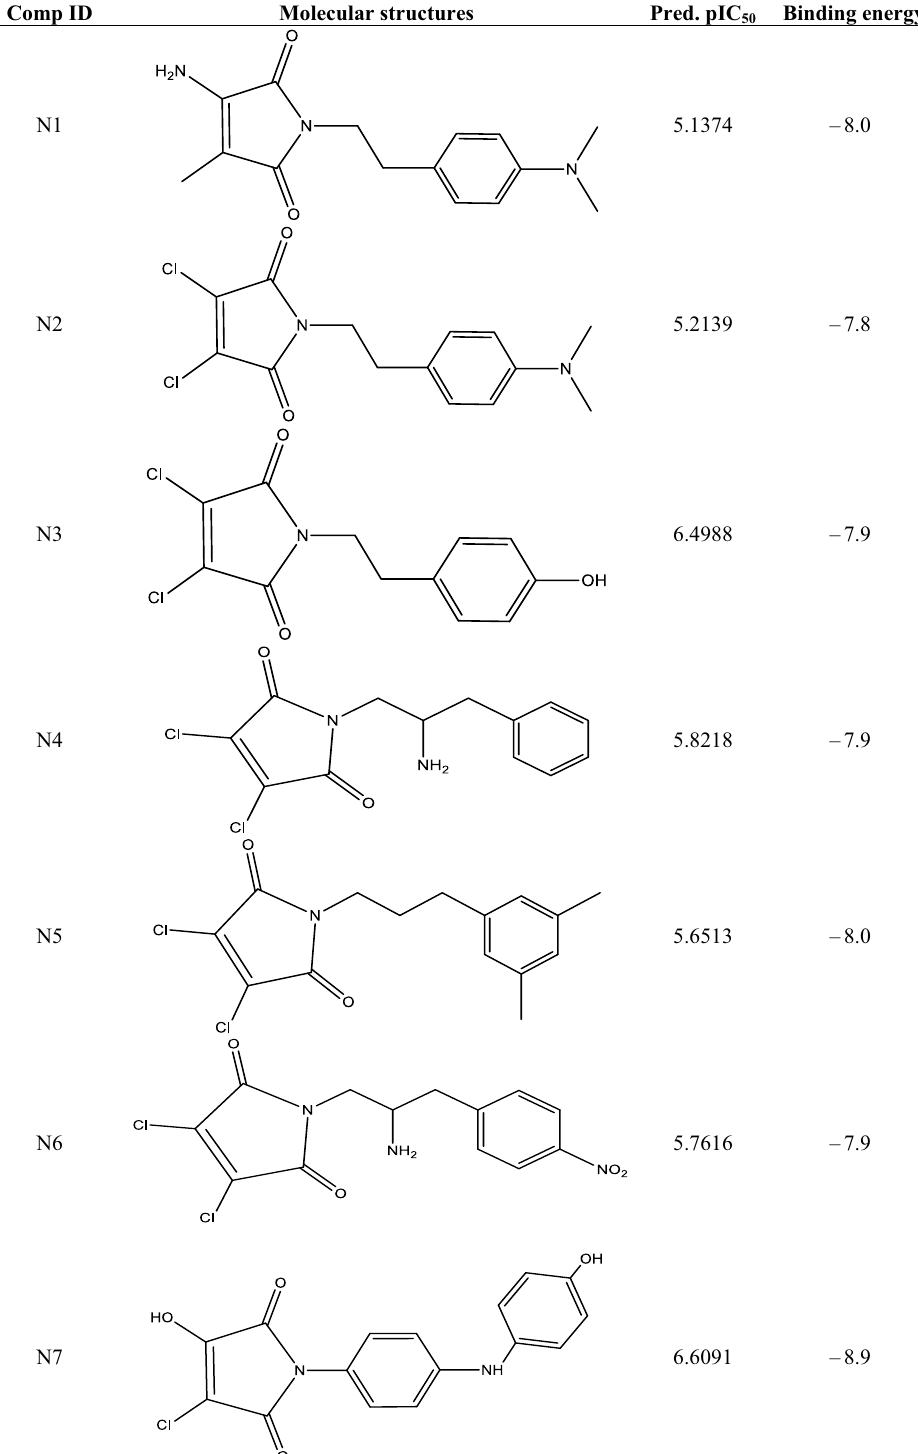
Table 11 Molecular structures, predicted pIC